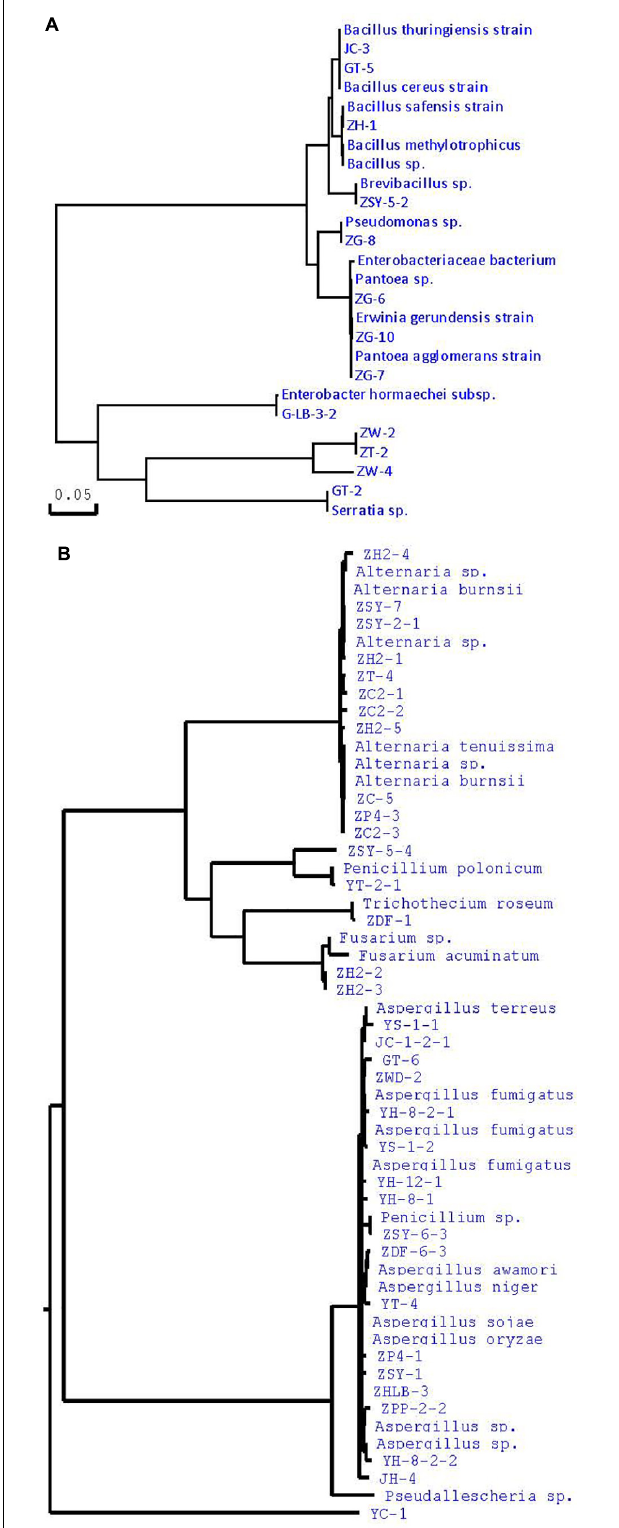
FIGURE 1 | Phylogenetic tree of partial sequence of endophytes from A . sinensis ( A , bacteria; B , fungi).